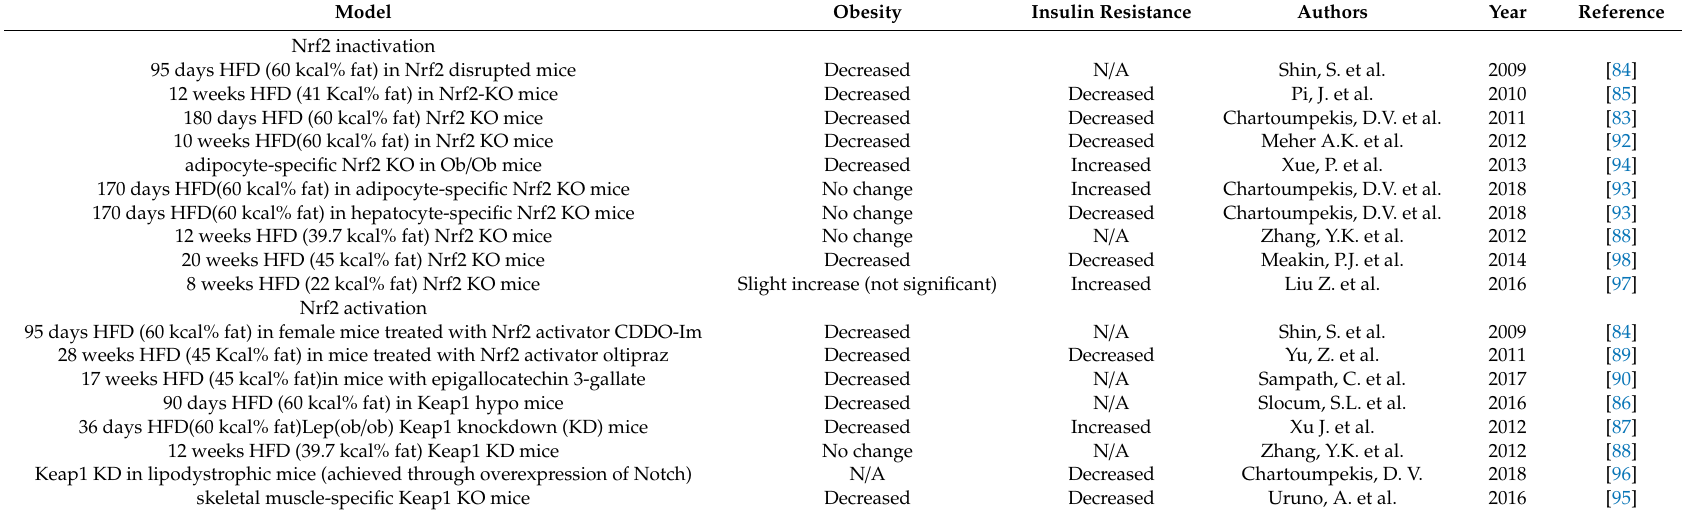
Table 1. The role of Nrf2 pathway in obesity and insulin